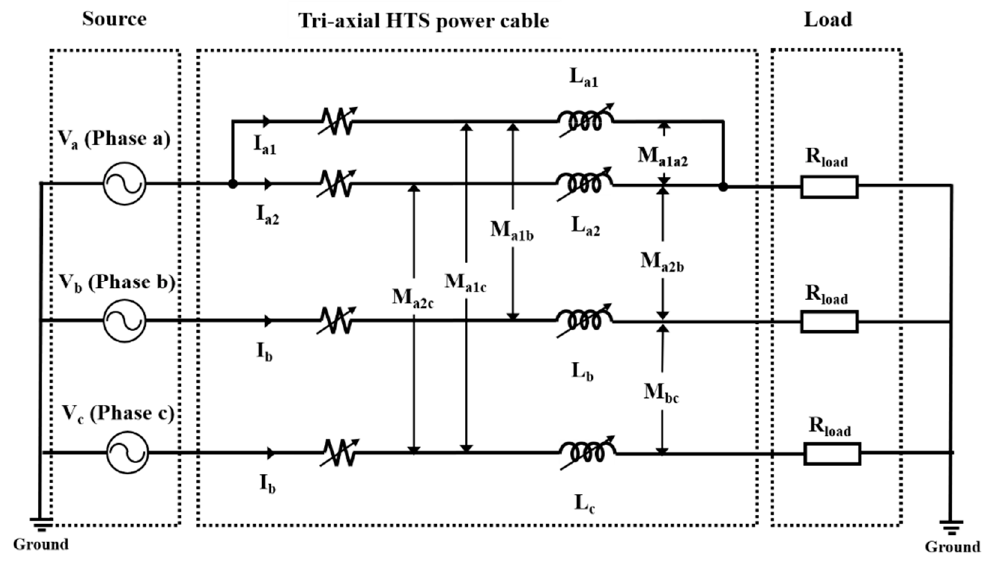
Energies 2020 , x , x FOR PEER REVIEW Figure 2. Electrical circuit diagram of the tri-axial HTS power cable. Figure 2. Electrical circuit diagram of the tri-axial HTS power cable.